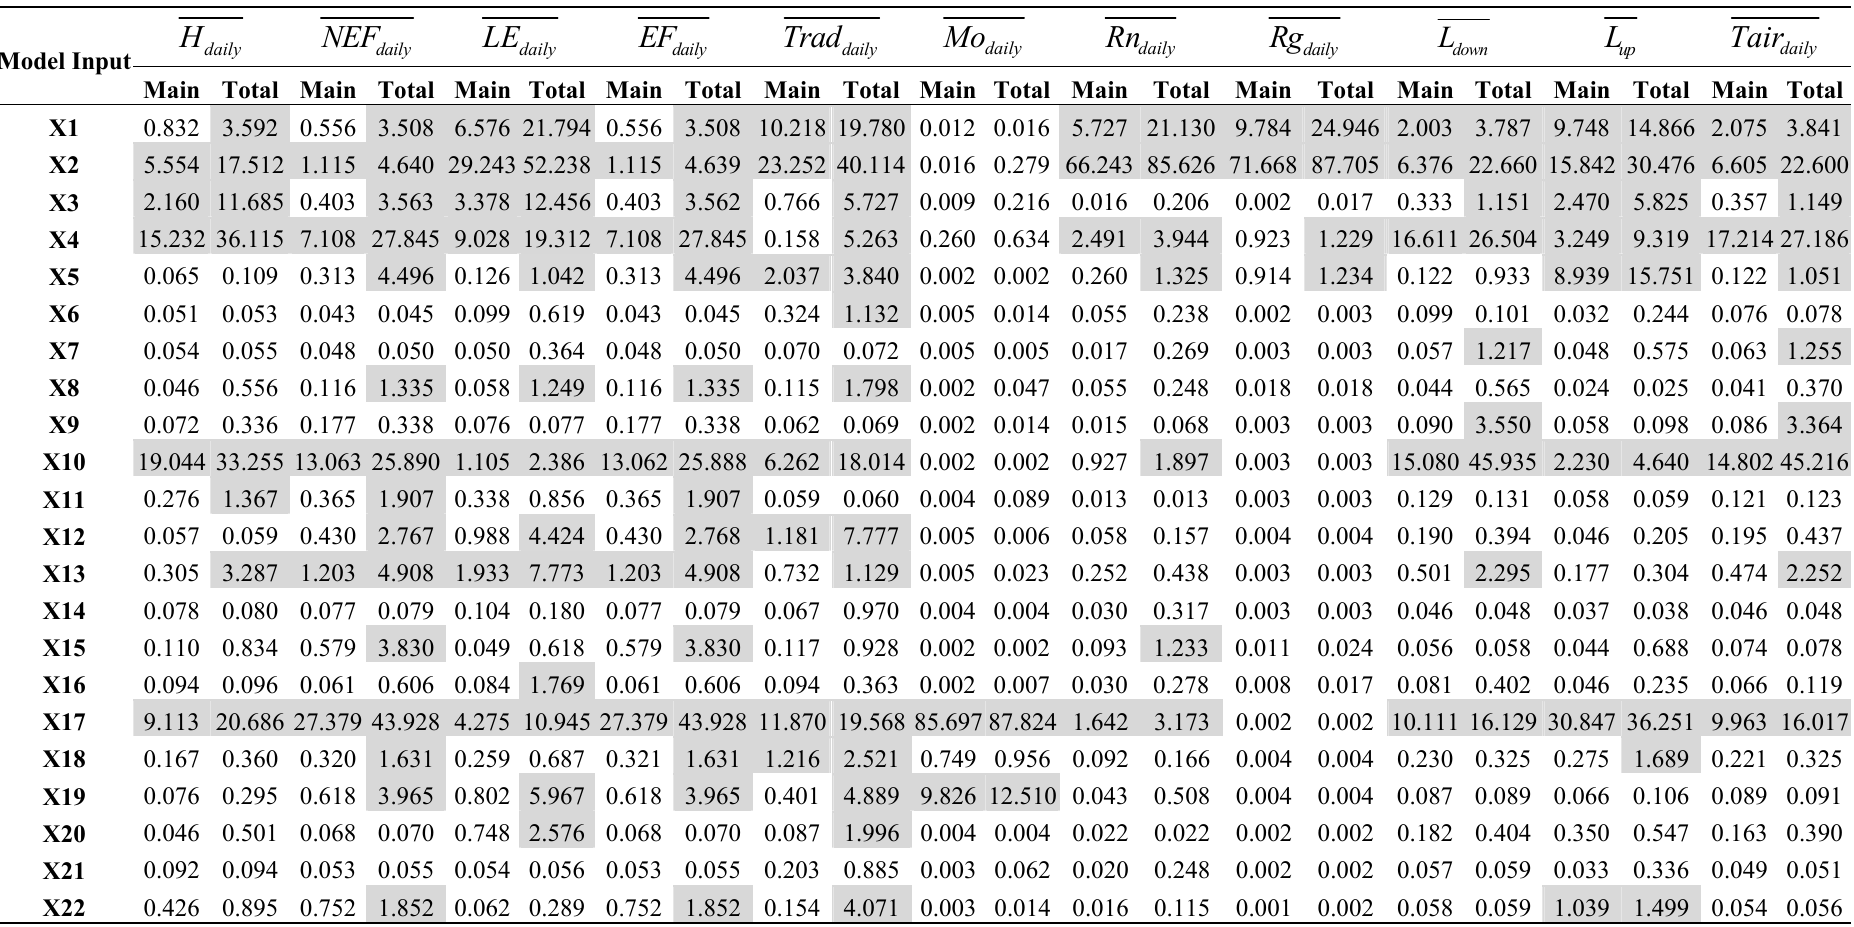
Table 8. Summarised results from the implementation of the BACCO GEM-SA method on the different outputs simulated by SimSphere using uniform PDFs at 15:30. Computed main (Main) and total effect (Total) indices by the GEM tool (expressed as %) for each of the model parameters are shown, whereas the last three lines summarise the percentages of the explained total output variance of the main effects alone (ME), the 1st order interactions only (1st) and the 2nd or higher order interactions only (>1st). Input parameters with a variance decomposition of greater than 1% are